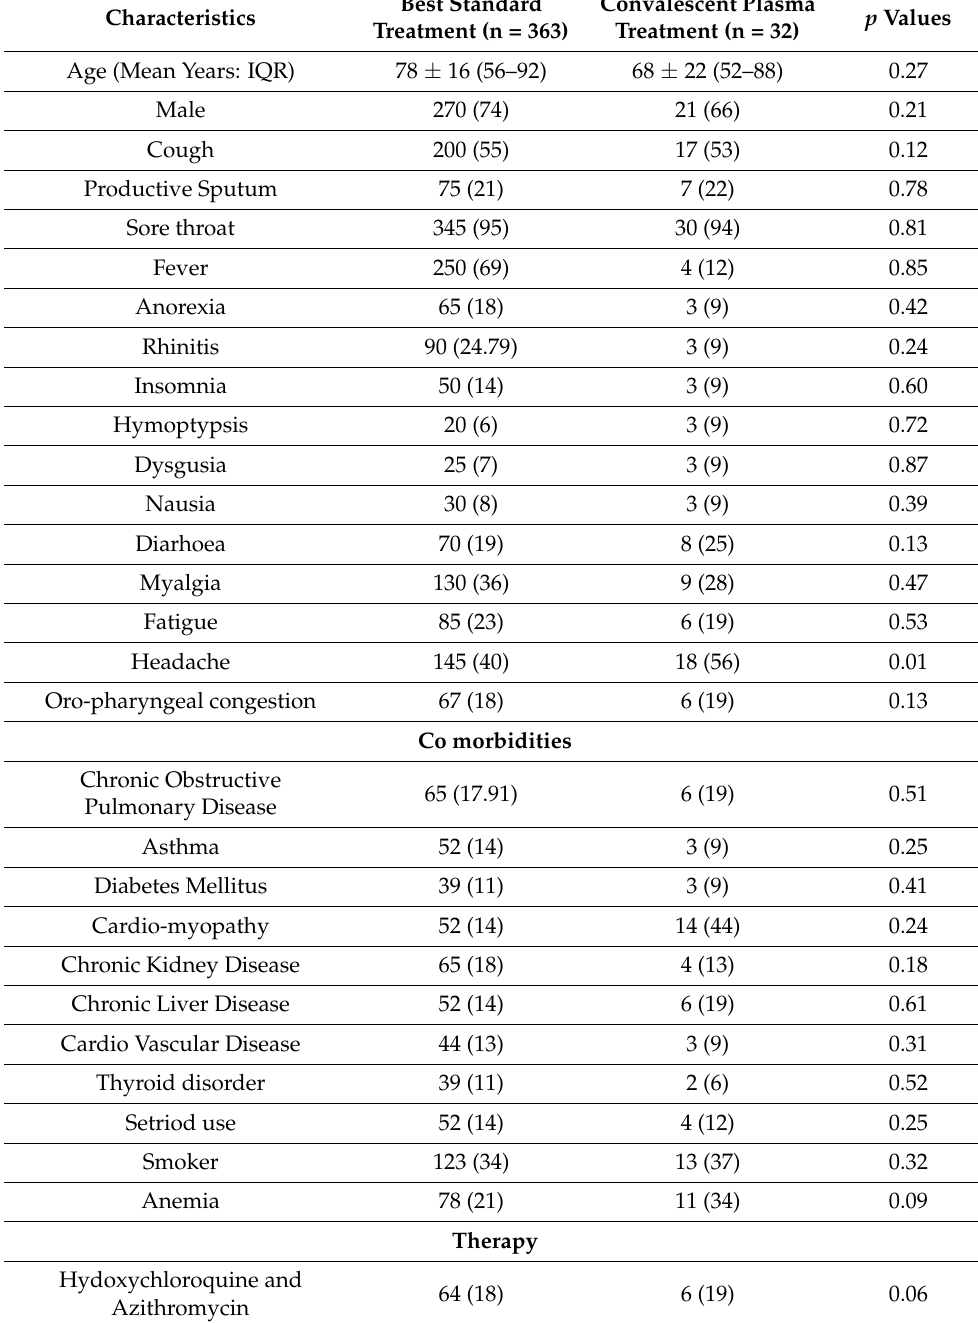
Table 1. Demographic and clinical characteristics of critically ill COVID-19 patients of best standard treatment group (n = 363) and convalescent plasma treatment group (n = 32). Best Characteristics